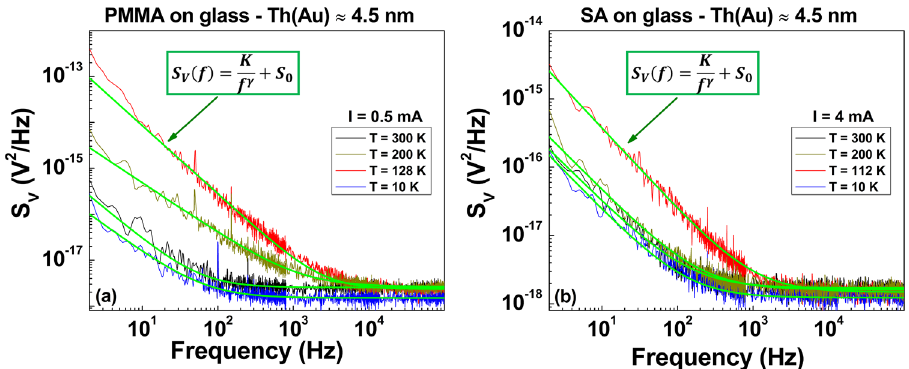
Figure 2. Voltage-noise spectra. The frequency dependence of S V , at fixed bias current values, is shown for PMMA ( a ) and for SA ( b ) films deposited on glass and covered with a 4.5 nm-thick Au layer. The green solid lines are the best fitting curves obtained by using Eq. (1).